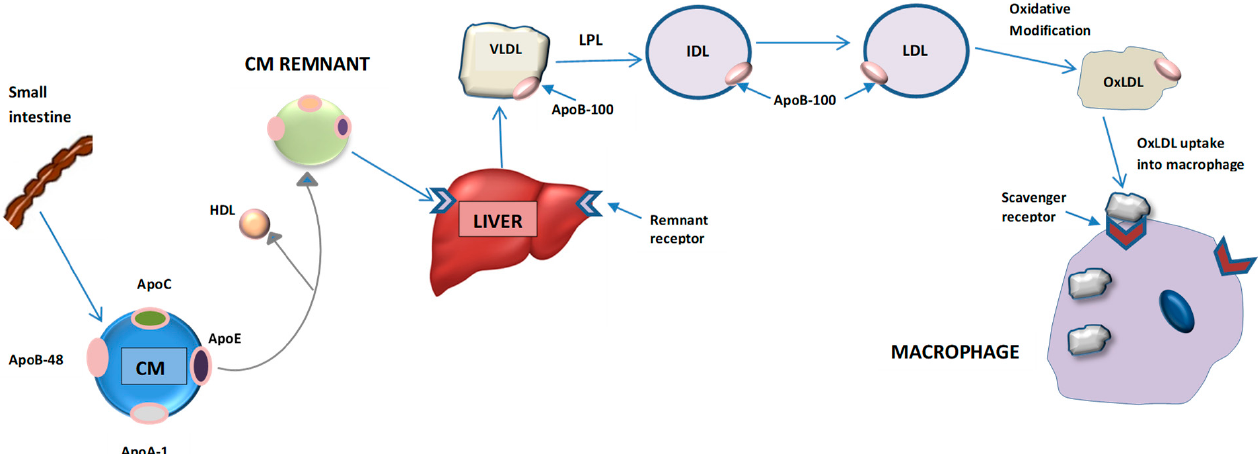
Figure 3. Apolipoprotein (apo) B in atherogenic lipoprotein formation. ApoB is the critical structural protein of all atherogenic lipoproteins. It has two major isoforms: apoB48 and apoB100. ApoB48 is found only in chylomicrons (CM) and chylomicron remnants. It mediates the secretion of chylomicron particles from the intestines. Chylomicron remnants are taken up by the liver. Free fatty acids generated from chylomicron remnants are used by the liver to make triglycerides that are incorporated into nascent VLDL. VLDL particles, each harboring a single apoB100 molecule, are secreted from the liver carrying endogenous, hepatically synthesized triglycerides. VLDL particles shrink with loss of surface components to HDL and are catabolized to IDL by lipoprotein lipase (LPL). Then, IDL is converted to LDL. It is LDL that carries the majority of the circulating cholesterol. LDL can be oxidatively modified and taken up by macrophages which leads to excess accumulation and the formation of foam